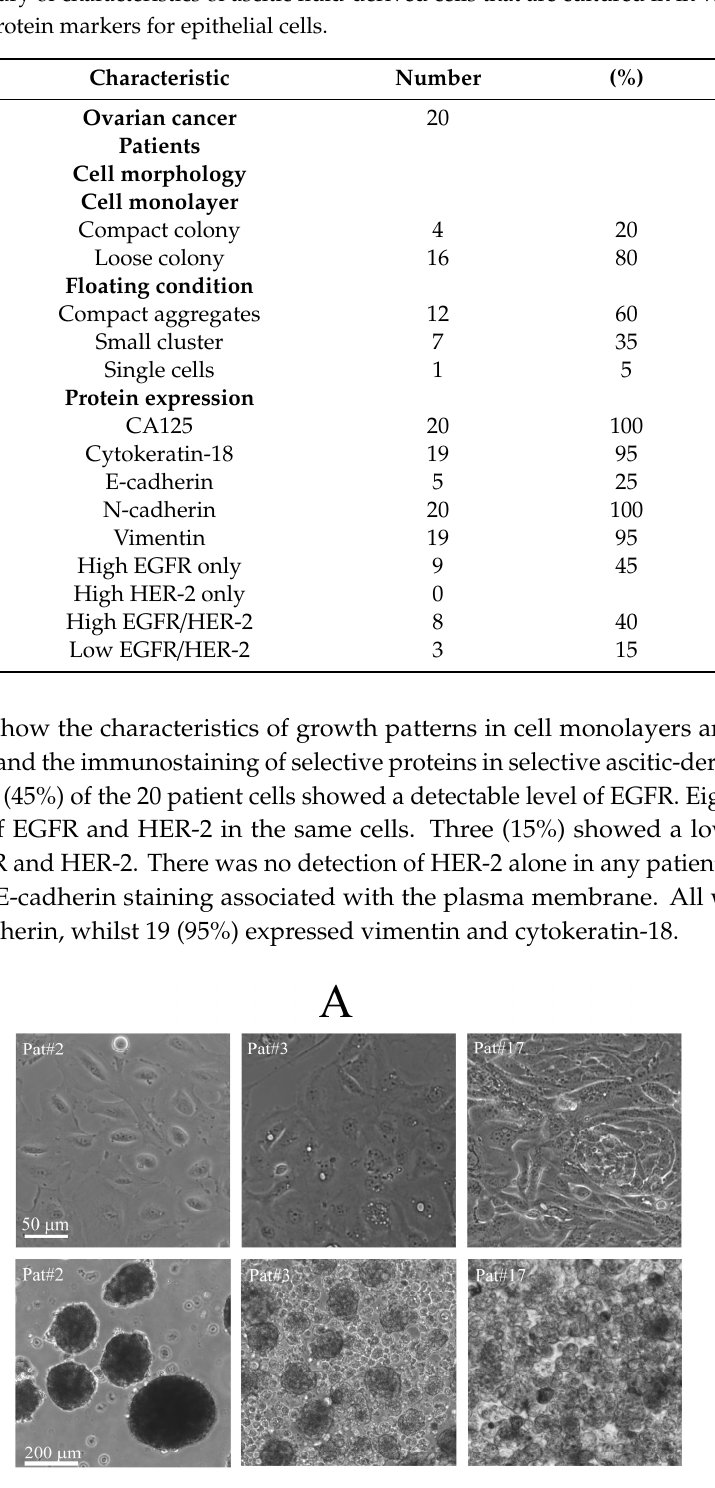
Figure 4. Morphological appearances of ascitic fluid-derived cells from selected patients are cultured in a cell monolayer and a 3D cell suspension. Cells cultured in the 3D cell suspension display three distinct patterns consisting of compacted spheroids, small clusters and loose single cells ( A ). Ascitic fluid derived cells from selected patients cultured in a 3D cell suspension positively express CA125, cytokeratin-18, N-cadherin, E-cadherin and vimentin ( B ). 3.6. Effects of Gefitinib and Canertinib on Cellular Viability Using Alamar Blue Dye Assay To study the effect of gefitinib and canertinib on the cell viability of EGFR and HER-2 positive ascitic-derived cells, we examined the cellular conversion of the Alamar blur dye, which was converted by cells from blue into pink colour, as an indirect predictor of cell viability. As shown in Table 3A, gefitinib and canertinib selectively reduced viability in the EGFR positive ascitic cells. Of nine ascitic cell samples, four gefitinib-treated ascitic cell samples (patient numbers 1, 4, 17, 19; p < 0.05) had lower viability than the control cells. Four canertinib-treated cells (patient numbers 4, 6, 17, 19; p < 0.05) also showed a reduction in cellular viability compared to the control cells. Both gefitinib and canertinib reduced viability in three patient cells (patient numbers 4, 17, 19). Canertinib (74.9% ± 4.3%, p < 0.05) reduced viability to a greater degree than gefitinib (84.6 ± 0.8) in patient number 4. Table 3B shows that ascitic cells expressing both EGFR and HER-2 did not reduce cellular viability after exposure to gefitinib. However, three out of eight EGFR and HER-2 positive ascitic cell